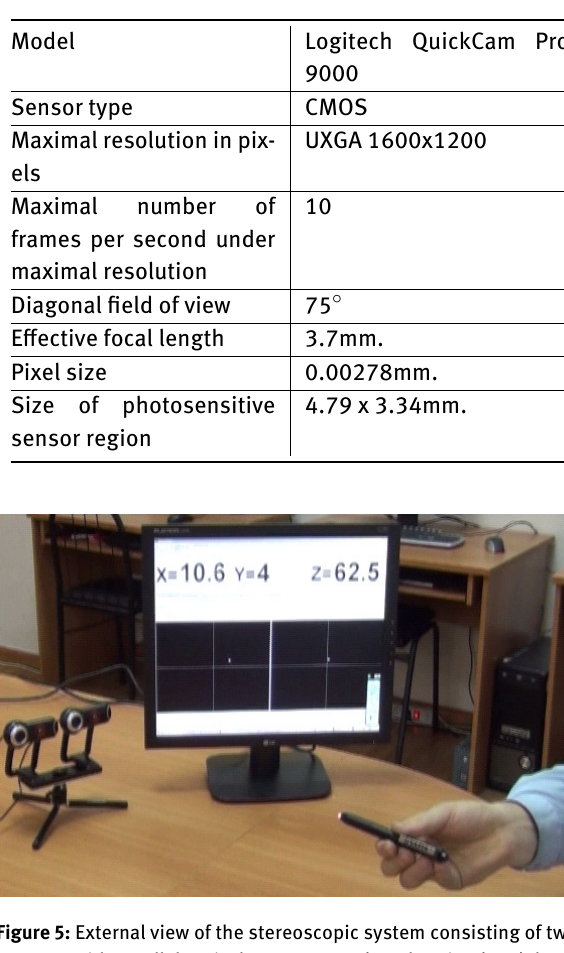
Table 1: Technical specification of the used cameras